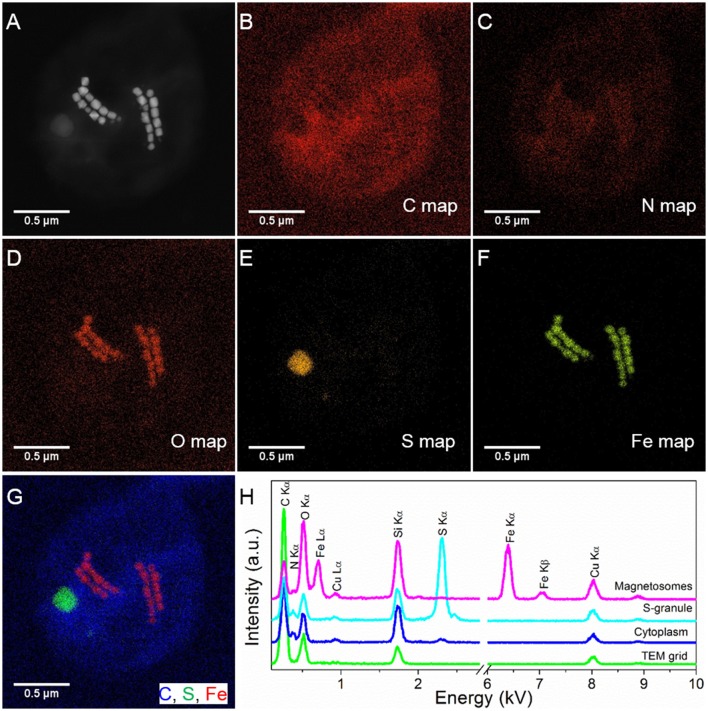
STEM-EDXS mapping (HAADF mode) of SHHC-1 cells. (A–F) HAADF-STEM image of a single SHHC-1 cell (A), and the corresponding chemical maps of C (C Kα) (B), N (N Kα) (C), O (O Kα) (D), S (S Kα) (E), and Fe (Fe Kα) (F). (G) Overlapped map of Fe (red), C (blue), and S (green). (H) EDXS spectra extracted from the carbon film covering TEM grid (green line), cell wall (blue line), sulfur-rich particle (light blue line), and magnetosomes (pink line).